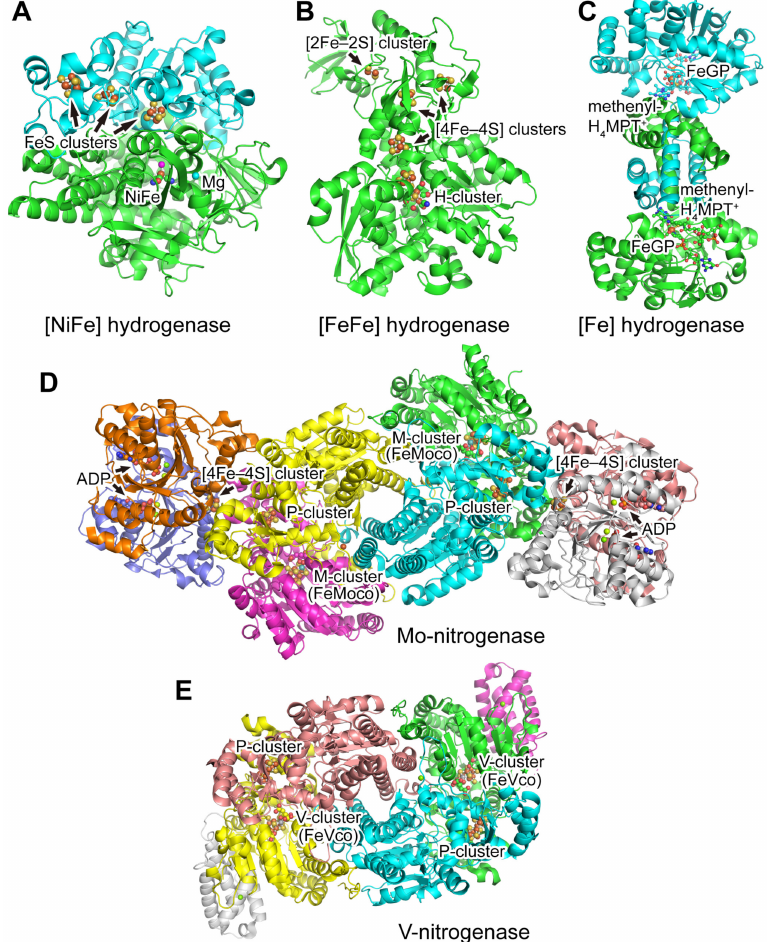
Figure 1. Structures of hydrogenases and nitrogenases. The proteins are shown as cartoons and different chains are colored differently. The metal clusters as well as other cofactors are labeled and shown as balls and sticks with the color codes according to the elements: C, the same color as the protein chain; N, blue; O, red; Fe, brown; Ni, magenta; Mo, dark cyan; V, dark gray; S, yellow; H, light gray; Mg, cyan; F, light cyan. ( A ) Structure of [NiFe] hydrogenase from Desulfovibrio vulgaris Miyazaki F (PDB 4U9H) [41]. ( B ) Structure of [FeFe]-hydrogenase from Clostridium pasteurianum (PDB 3C8Y) [42]. ( C ) Structure of [Fe]-hydrogenase from Methanocaldococcus jannaschii (PDB 3DAG) [38]. ( D ) Structure of Mo-nitrogenase from Azotobacter vinelandii (PDB 7UTA) [43,44]. ( E ) Structure of V-nitrogenase from Azotobacter vinelandii (PDB 5N6Y)